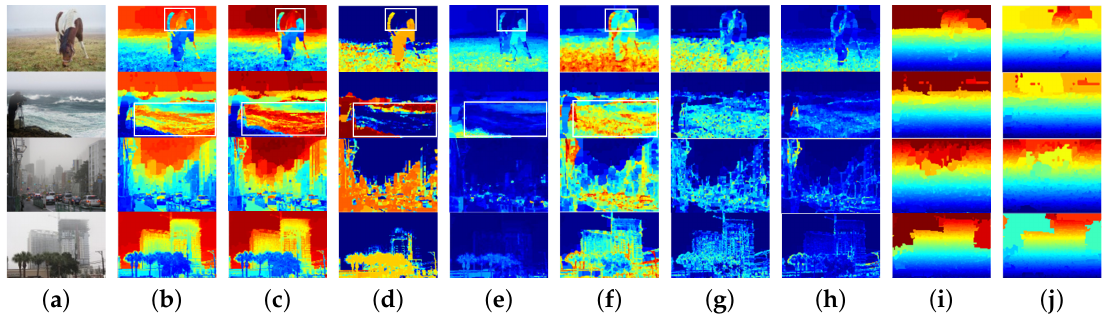
Figure 3. Haze-relevant features used in this paper. ( a ) Hazy images; ( b ) dark channel; ( c ) depth of scene; ( d ) hue disparity; ( e ) color saturation; ( f ) contrast energy; ( g ) Canny edge; ( h ) color gradient; ( i ) maximum height; ( j ) minimum